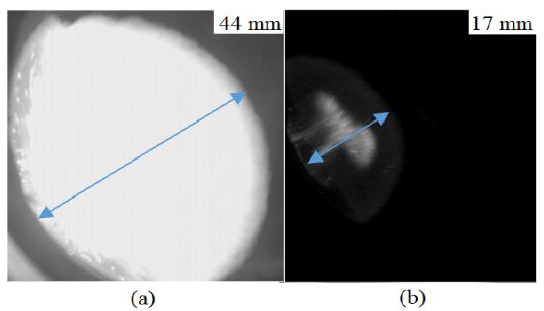
Figure 5. Film propagation speed at 3 ms after ignition; ( a ) diesel; ( b ) bio-diesel 10%.